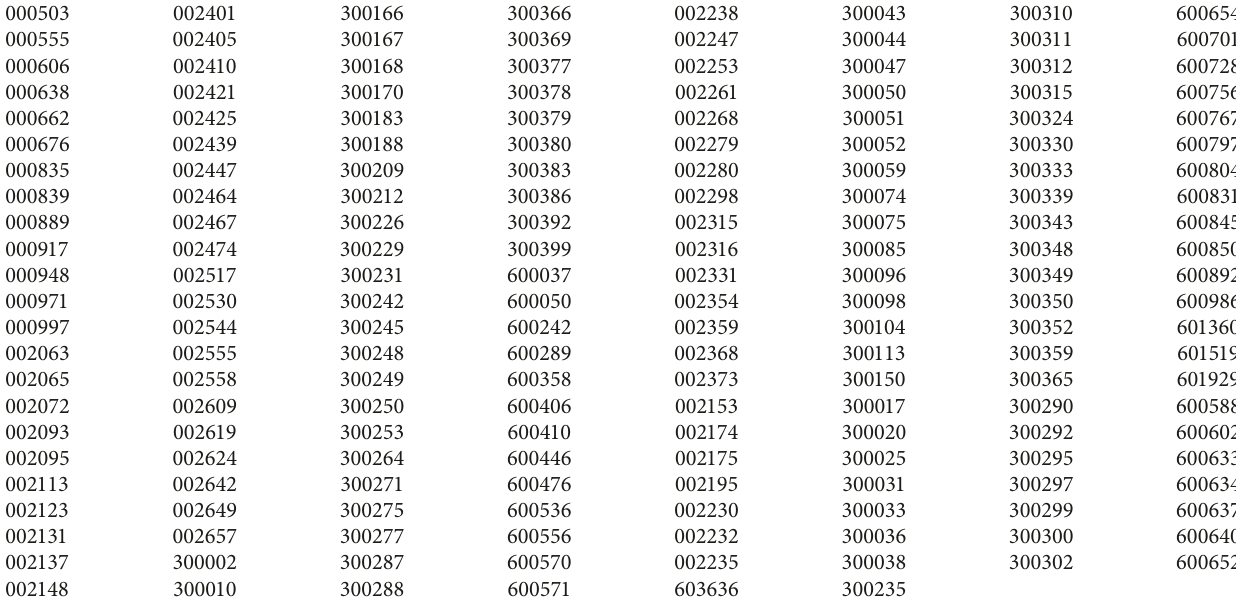
Table 1: 182 listed company stock codes.